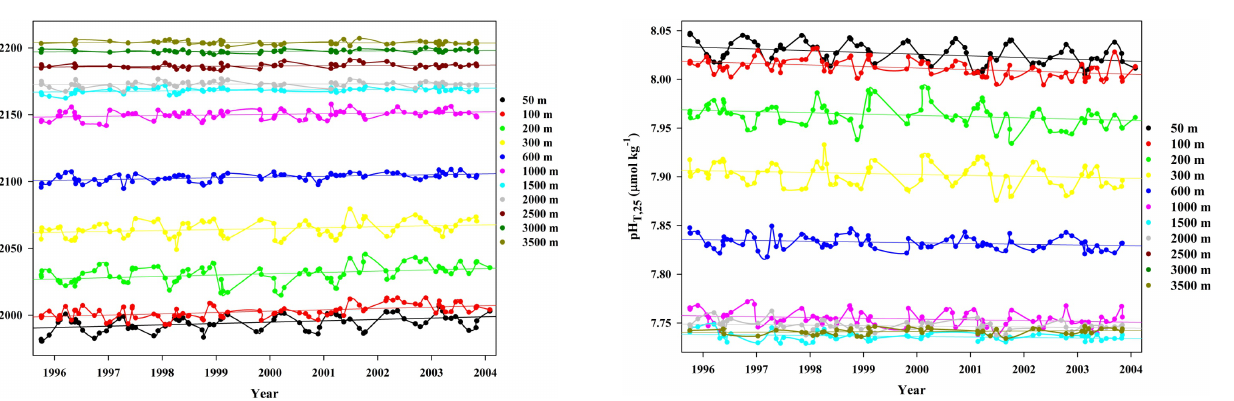
Fig. 4. Long-term trends of the water column C T normalized to a constant salinity of 35, NC T (µmolkg − 1 ) for the mixed layer and for selected depths at ESTOC. The slope and standard deviation of the linear regressions are presented in Table 1.